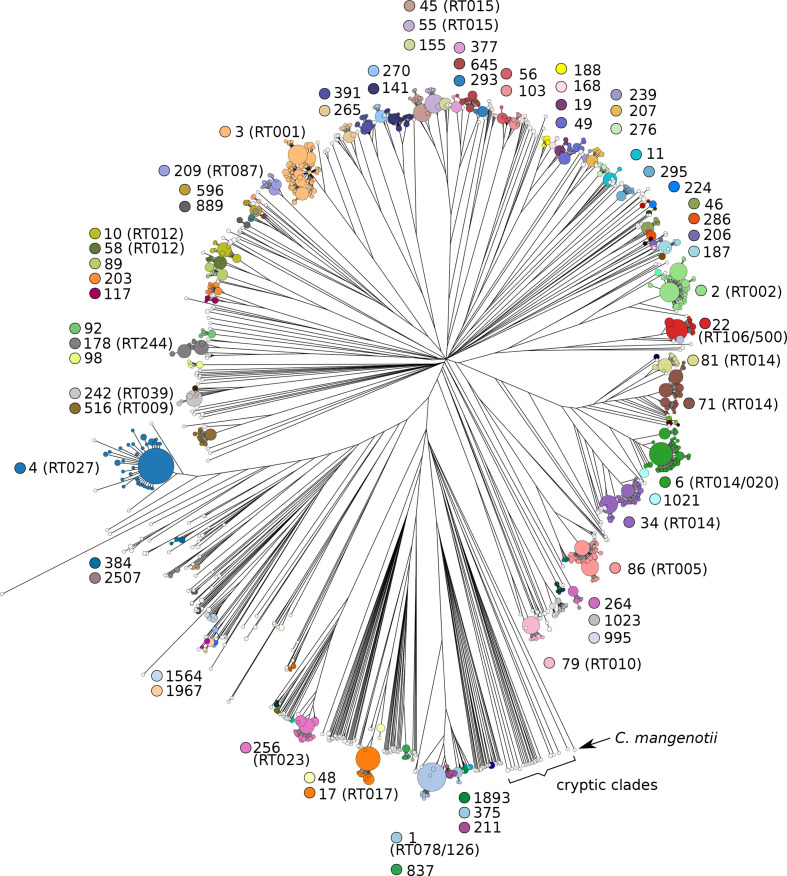
Rapid-neighbour-joining phylogenetic tree based on cgMLST variation from 13 515
C. difficile
 genomes. Colours and numerals indicate CCs (HC150 clusters) with ≥10 entries, and information on predominant PCR ribotypes is provided in brackets.